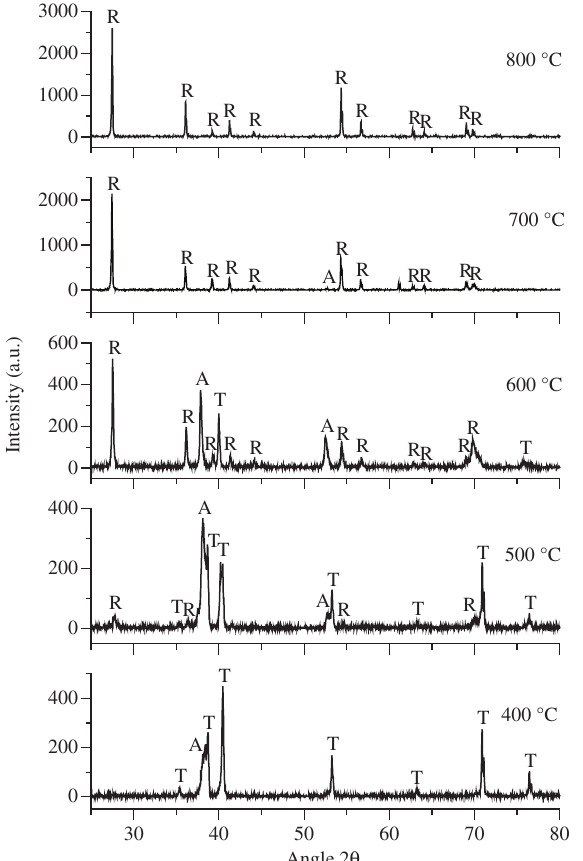
Figure 3. XRD patterns of titanium surfaces oxidized 48 hours in air (T = ti- tanium, A = anatase, R = Rutile).